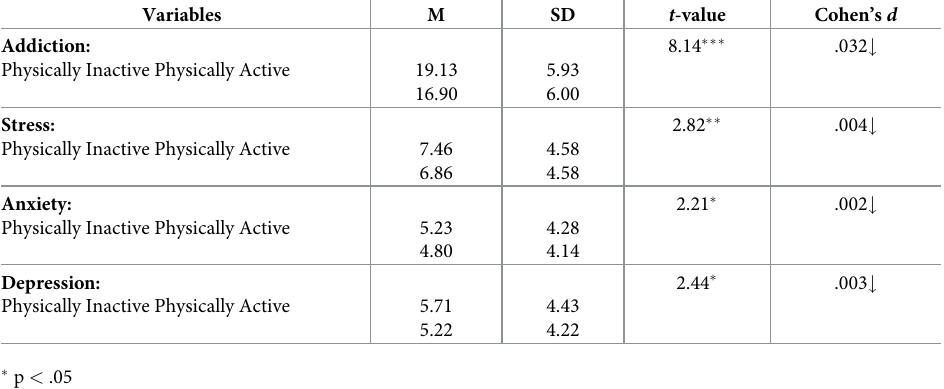
Table 8. T -tests comparing physically inactive students (n = 1,194) and active students (n = 788) in the study vari- ables (df =